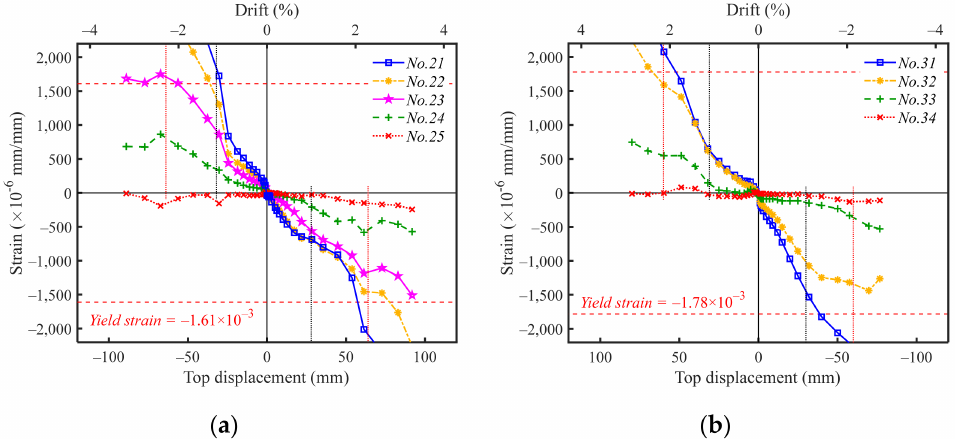
Figure 21. Comparison of strain results on end column. ( a ) W1-R; ( b ) W2-R.